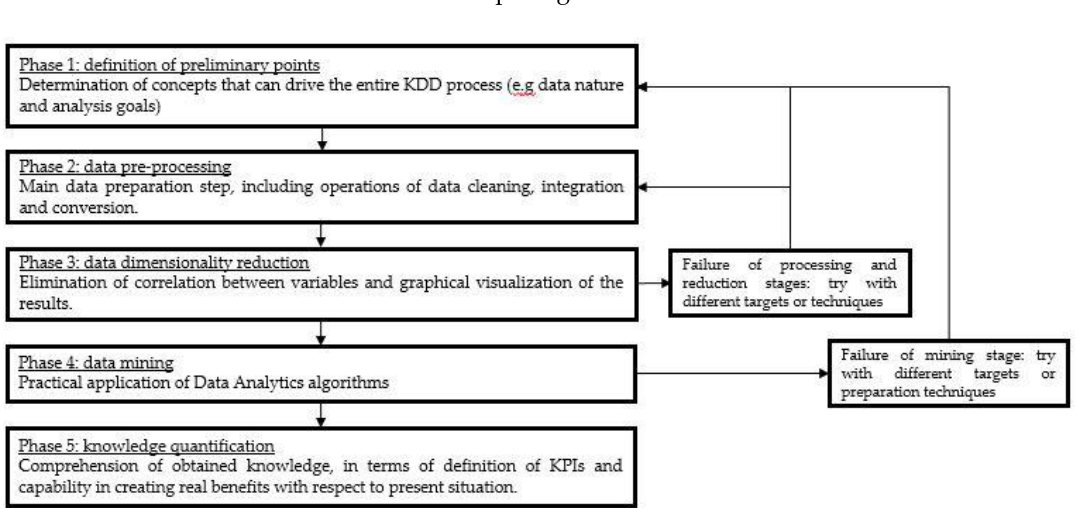
Figure 2. Logical structure of a general KDD process for which raw data are the global input.